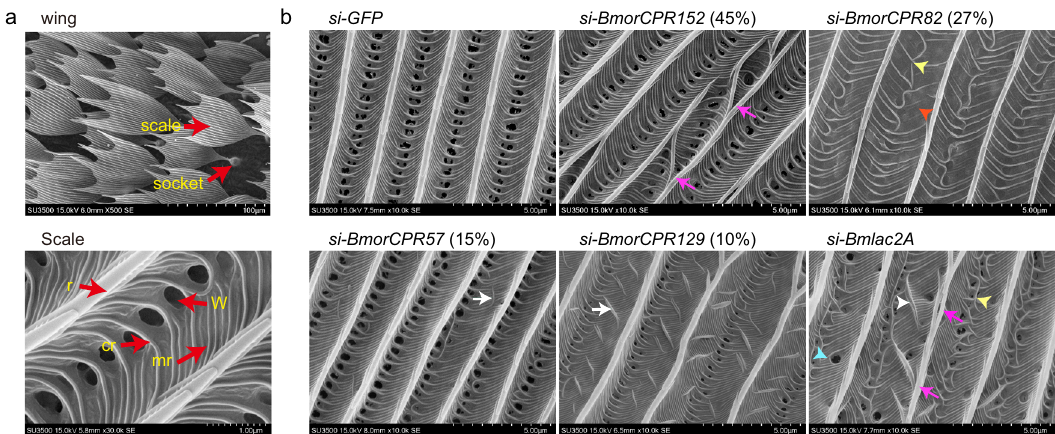
Fig. 3 Scale microstructure before and after injection of siRNA directed against His-rich CPs and Bmlac2A . a Microstructure of scales in wildtype wing. Upper panel, low magni fi cation SEM image (wing). Lower panel, high magni fi cation SEM image (scale). Red arrows show: cr crossrib, mr microribs, r ridge, W window. b Knockdown experiments of His-rich CPs and BmlacA2 . Compared to Control (siRNA for GFP ), depletion of mRNAs of His-rich CP genes BmorCPR152 (45% His), BmorCPR82 (27% His), BmorCPR57 (15% His), or BmorCPR129 (10% His) caused scale abnormalities. Reduction of Bmlac2A mRNA in the pupal stage caused severe damage to scales, which seemed to encompass reduction of all His-rich CP mRNAs. magenta arrows, abnormal ridges; orange arrowhead, lack of microribs; white arrowheads, unexpected striations intersecting the microribs; blue arrowhead, extra window; yellow arrowheads, intertwining of cross ribs at the window region.